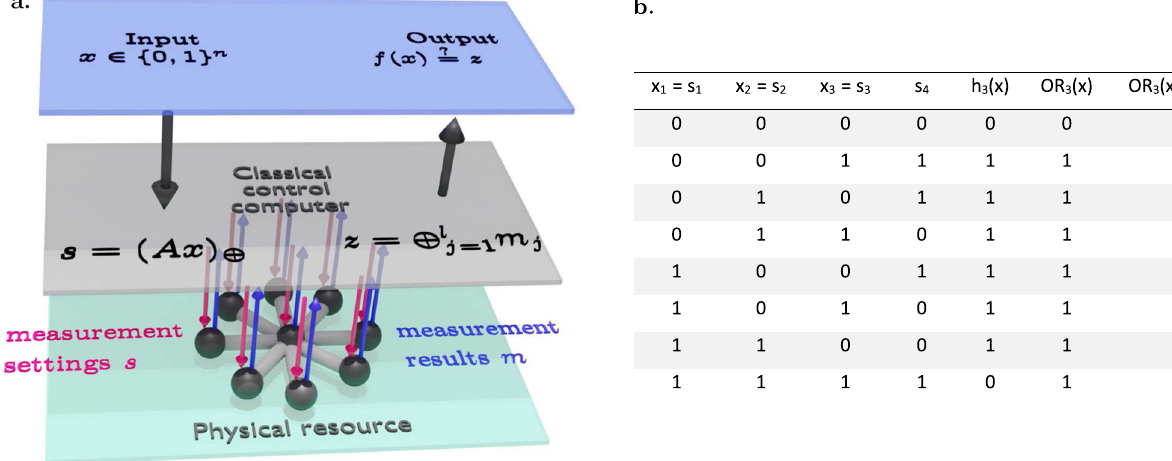
Fig. 2 NMQC and Boolean functions. a Concept of our setting to compute a Boolean function f ( x ) as described in the main text. The input x is transformed into a bit string s which determines the measurement settings M j ( s j ) on the physical resource. The outcomes of these measurements m j determine the results of the computation: z : ¼ measurements. b Truth table for the three functions considered in this work with input string x = ( x 1 , x 2 , x 3 ) and the bit string s = ( s 1 , s 2 , s 3 , s 4 ) (see main text for